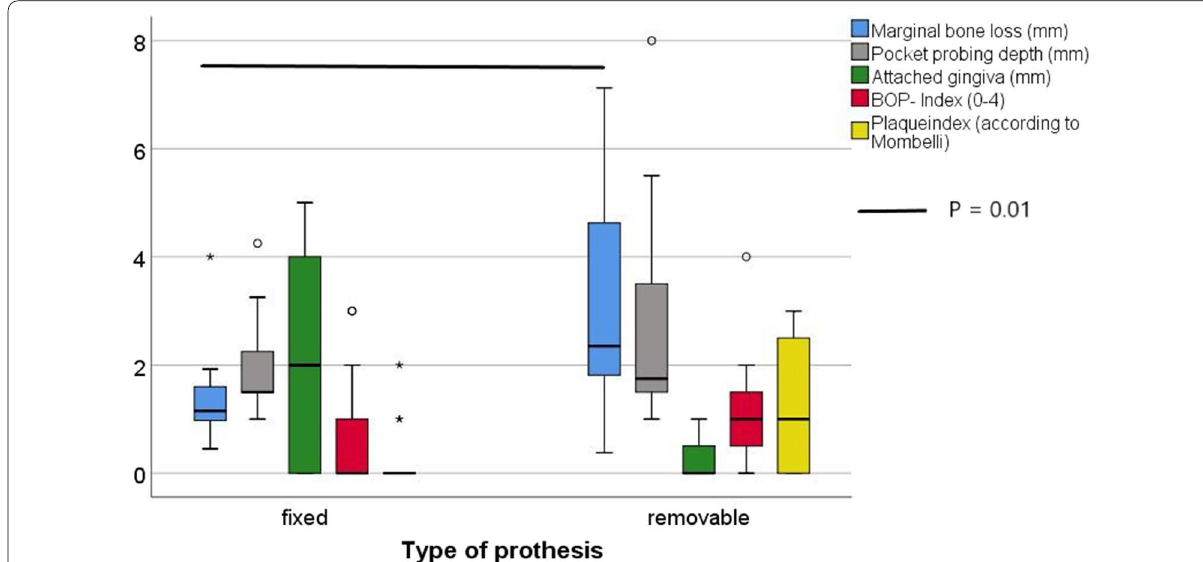
Fig. 6 Comparison of clinical and radiographic findings categorized in two groups according to type of dental prosthesis. Statistically significant differences were identified solely for the parameter “marginal bone